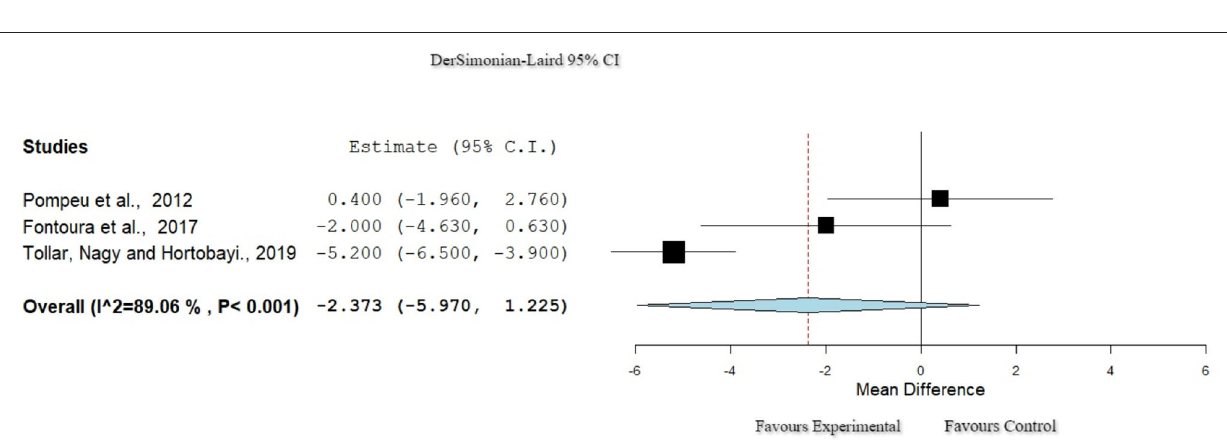
FIGURE 4 | Forest plot for ADL: UPDRS II. The red dash line represents the weighted mean difference of the included studies. The blue figure represents the weighted 95% CI of the included studies. ADL, activities of daily living; UPDRS II, Unified Parkinson’s Disease Rating Scale Part